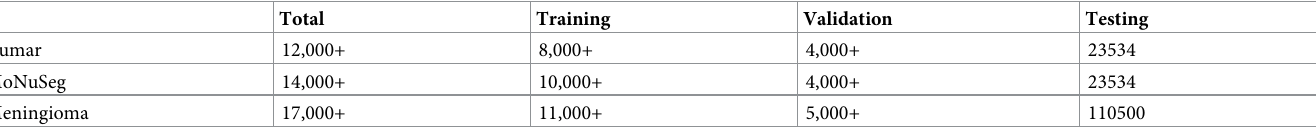
Table 3. Division of original images for training and testing datasets.